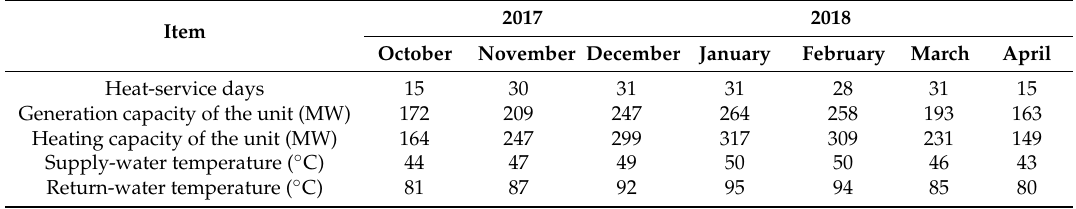
Table 5. Average operating parameters of the reference HBP-CHP unit in different months of the heating season from 2017 to